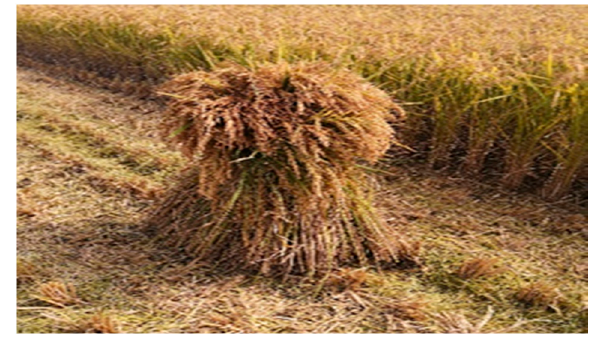
Figure 7. Rice baling test in Jilin city.